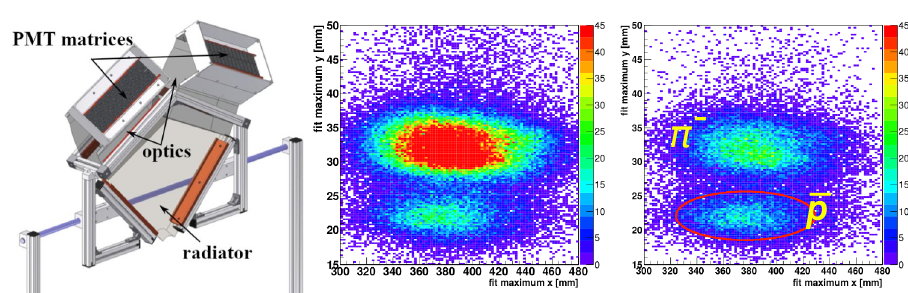
Figure 2. Left: Plexiglas DIRC geometry. Middle / Right: Preliminary separation of antiprotons and pions in the plexiglas DIRC without (middle) and with (right) a cut on a signal from aerogel Cherenkov